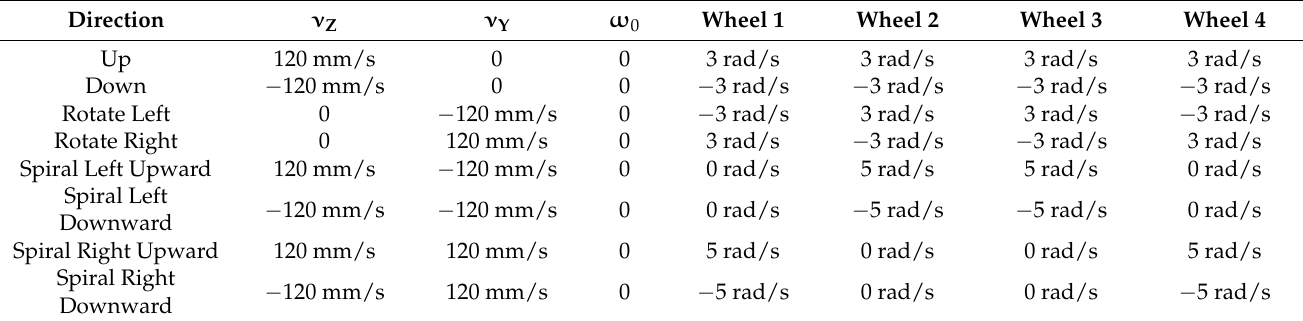
Table 3. Assumed Velocities and Results.